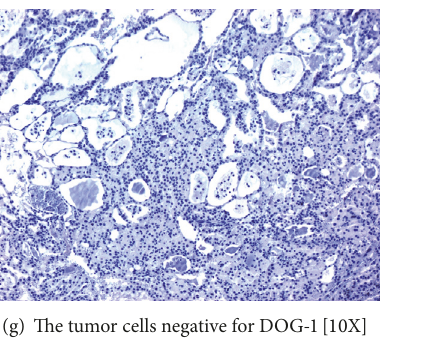
Figure 1: SC of parotid gland, epithelial neoplasm with a lobular growth pattern, and solid microcystic areas (a-b) [H/E 10X and 40X]. Tubular structures showing abundant, foamy, PAS- and Alcian Blue-positive intraluminal material (c-d). The tumor cells positive for S100 and mammaglobin (e-f), but negative for DOG-1